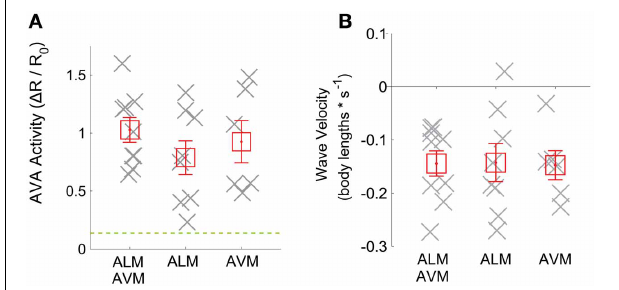
FIGURE 3 | (A) Mean of AVA activity and (B) worm velocity during a time window are shown (gray crosses) for trials when the worm reversed in response to optogenetic illumination of ALM ( n = 8 trials), AVM ( n = 6 trials) or both ( n = 9). Mean across trials is shown (red squares). Error bars represent standard error of the mean. The dashed green line shows the mean plus standard deviation of the apparent calcium signal observed during reversals in worms expressing calcium-insensitive GFP instead of GCaMP3 ( n = 5 trials).